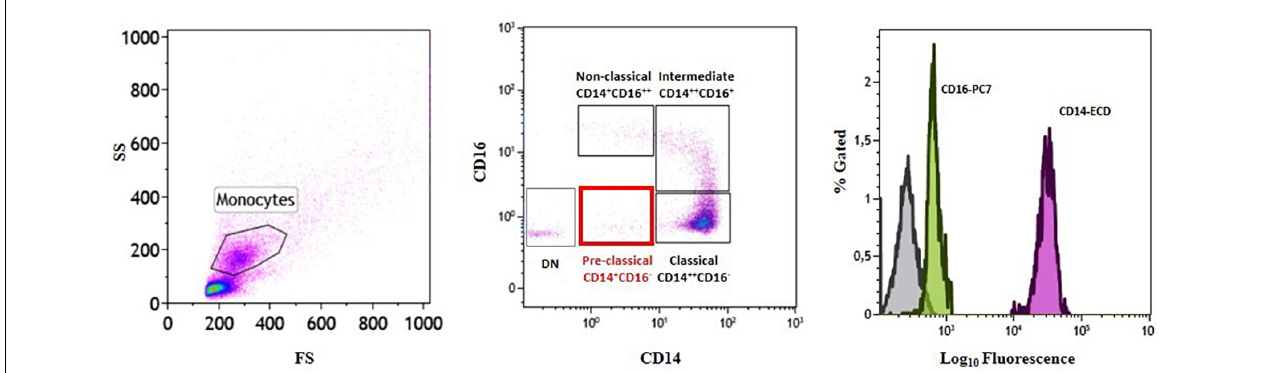
FIGURE 2 | Identification of a novel subset of circulating monocytes.Gating strategy and monocyte subset identification by flow cytometry in a representative patient. Monocytes were gated in a forward/sideward scatter (FS/SS) dot plot (left plot) and the three monocyte subsets (classical, intermediate, and non-classical) (middle plot) as well as the novel pre-classical monocyte population were identified according to CD14 and CD16 cell surface expression (right histogram). DN = double negative.